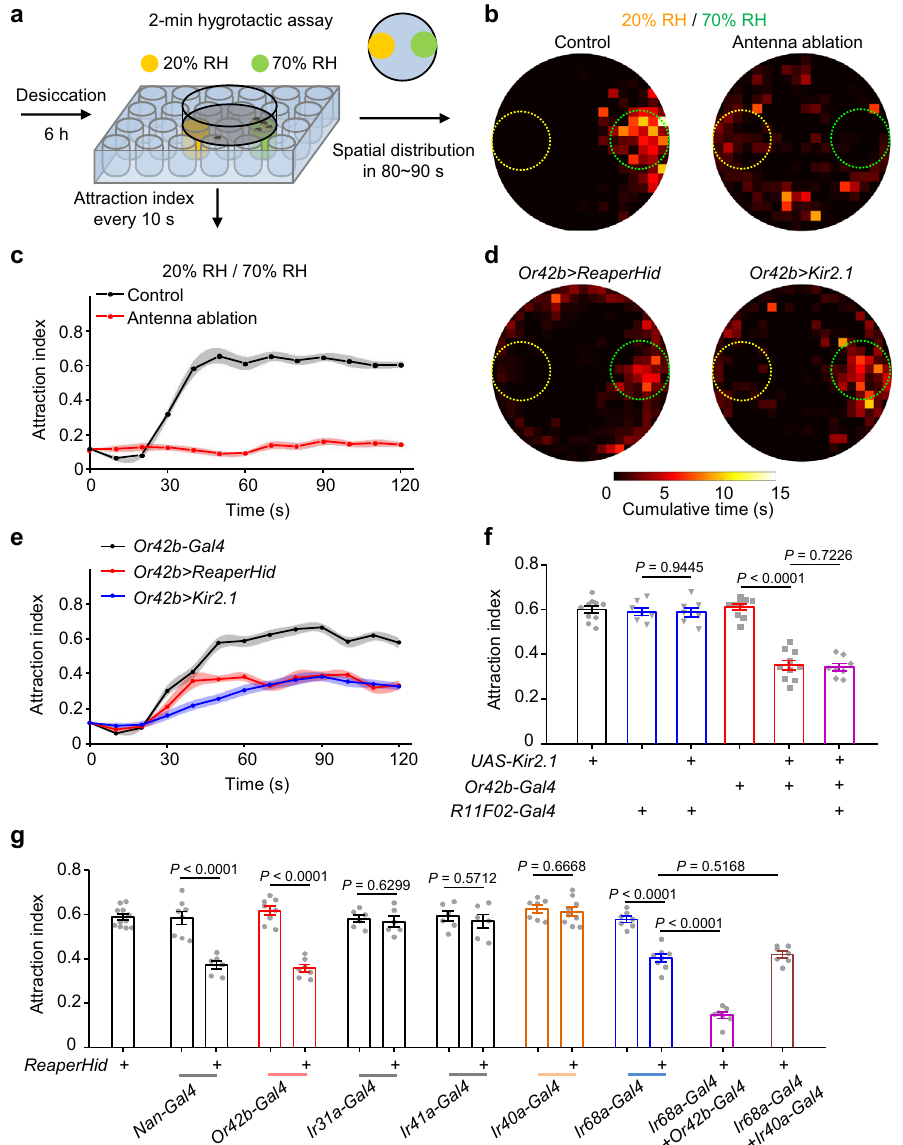
Fig. 1 Humidity-guided attraction to 70% RH requires Or42b OSNs. a Schematic diagram of the humidity-induced attraction behavioral assay. The yellow region represents 20% RH generated by saturated LiCl solution, and the green region denotes 70% RH produced by saturated NaCl solution. A total of 20 – 40 fl ies were used per assay. b Spatial distribution of control fl ies (left) and fl ies with the antennae removed (right) assayed in a 20% to 70% RH gradient. w 1118 fl ies were used as control fl ies. Control, n = 22 fl ies; Antenna ablation, n = 20. The yellow dashed circle denotes the area above 20% RH, and the green circle indicates the 70% RH region. Color intensity represents the cumulative time the fl ies spent on each pixel during 80 – 90 s after the onset of the assay. c The time course indicating the attraction indexes of control and antenna-ablated fl ies. Control, n = 14 assays; Antenna ablation, n = 10. d Spatial distribution of Or42b > ReaperHid (left) and Or42b > Kir2.1 (right) fl ies assayed under the 20% to 70% RH condition. Or42b > ReaperHid , n = 24 fl ies; Or42b > Kir2.1 , n = 25. e The time course indicating the attraction indexes of fl ies carrying indicated transgenes. Or42b-Gal4 , n = 12 assays; Or42b > ReaperHid , n = 7; Or42b > Kir2.1 , n = 11. f Attraction indexes after inhibiting thermosensory neurons or Or42b- expressing neurons or both. n = 10, 7, 7, 9, 10, 8 assays. g Humidity-guided attraction to 70% RH in fl ies with removal of different neuron groups by crossing UAS-ReaperHid with the indicated Gal4 lines. n = 11, 8, 6, 8, 7, 6, 6, 6, 6, 7, 9, 7, 8, 7, 7 assays. Two-tailed unpaired t test for two groups, one-way ANOVA followed by Holm-Sidak ’ s test for multiple comparison. For ( c ), ( e ), data points are mean values and shaded area represents ± SEM. For ( f ), ( g ), data are mean ± SEM. Source data are provided as a Source Data fi neuron function (Fig. 1d – f). Or42b-Gal4 labels a single group of OSNs innervating large basiconic sensilla (ab1 sensilla) 27 – 31 . This